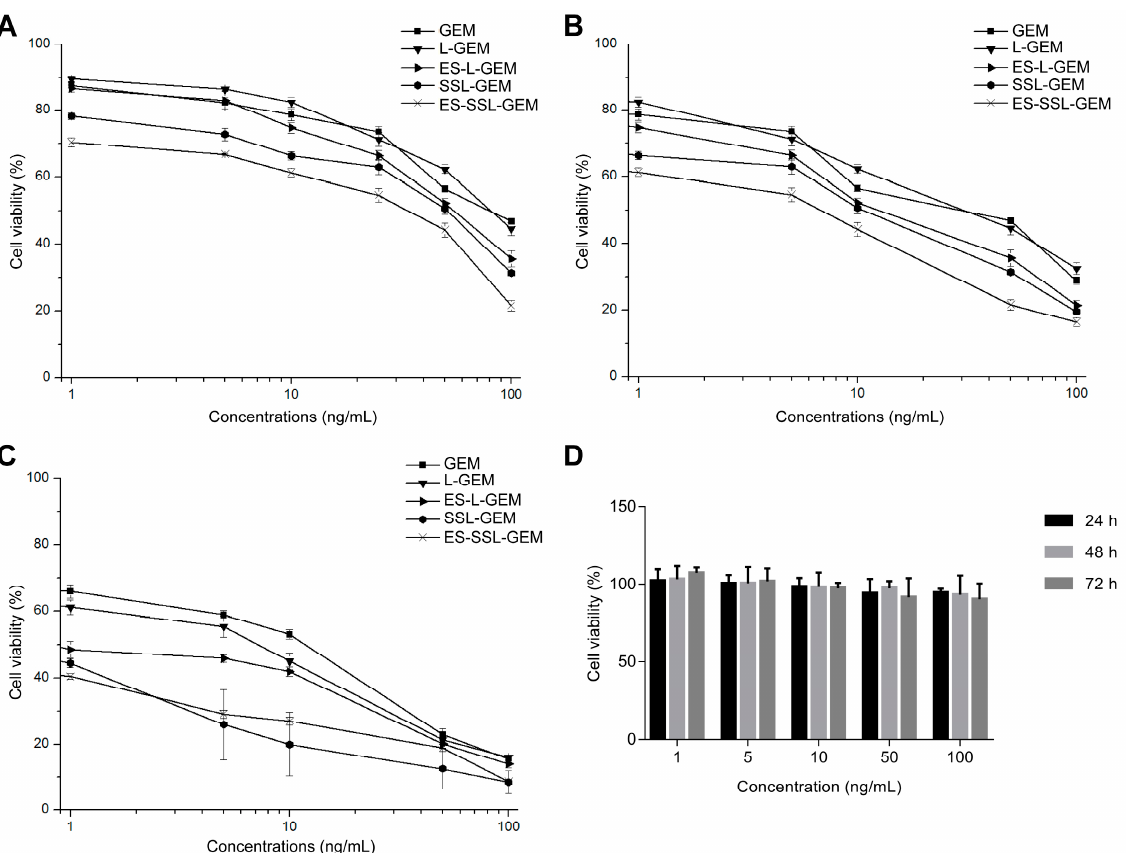
Figure 5. Cell viabilities of A549 cells after incubation with GEM, L-GEM, ES-L-GEM, SSL-GEM, or ES-SSL-GEM for ( A ) 24 h, ( B ) 48 h, and ( C ) 72 h (n = 3). ( D ) Cell viabilities of L929 cells after incubation with Blank-ES-SSL for 24 h, 48 h, and 72 h (n = 3). Table 2. IC 50 values (ng/mL) of different GEM formulations on A549 cells (n = 3). Formulation